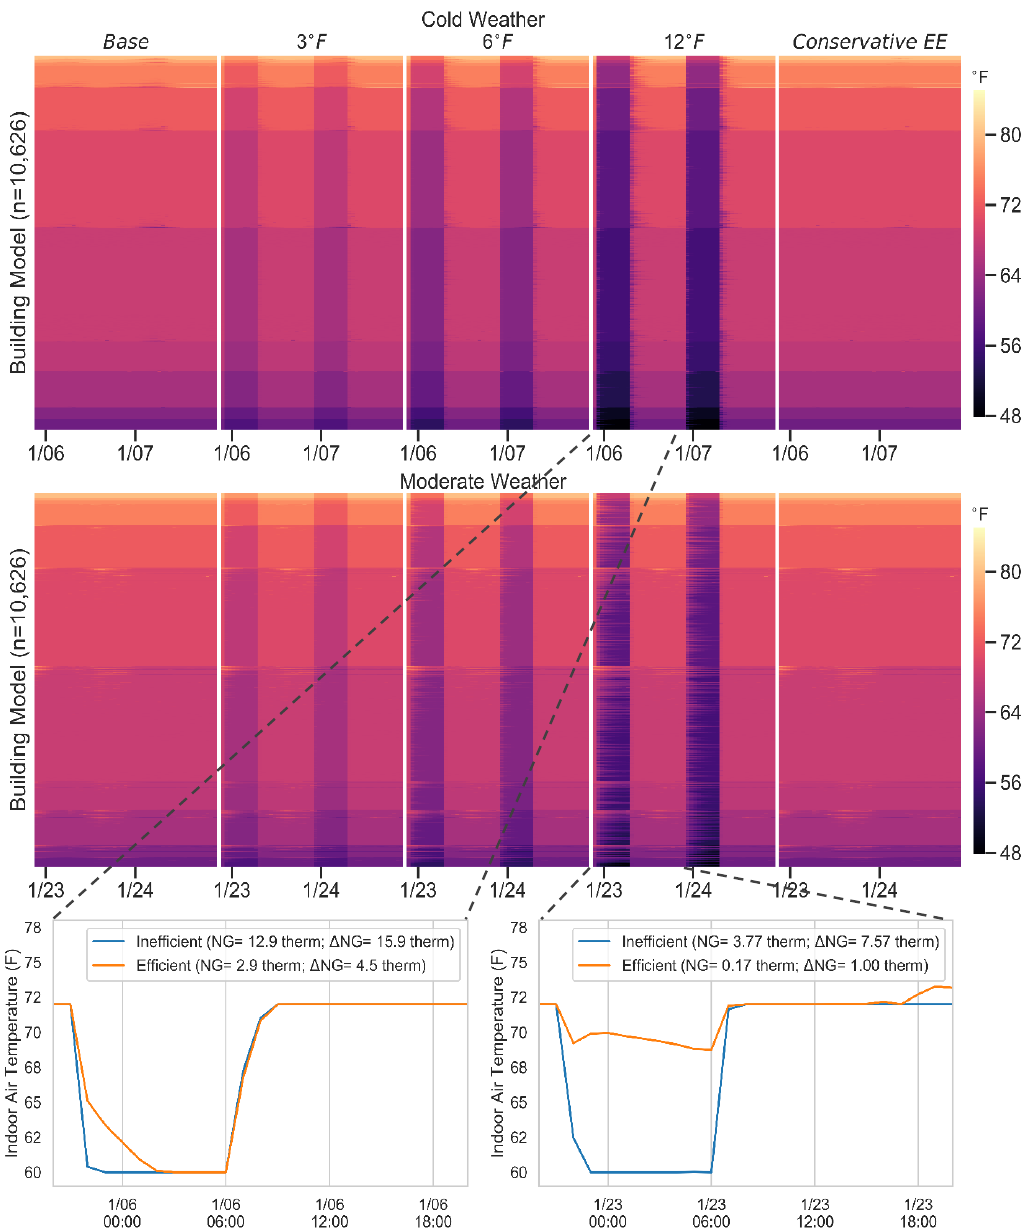
Figure 9. Heatmap of indoor air temperatures for the conservative approach during cold temperature ( top ) and moderate temperature ( bottom ) periods in 2018. The y -axis contains each building model for which the conservative setback was applied (46% of homes) and is sorted by average indoor air temperature. The lower two plots show expanded views of indoor air temperatures for two homes over 24 h during the cold period ( left ) and the mild period ( right ). One model is well insulated and tightly sealed (“Efficient”) and the other is poorly insulated and poorly sealed (“Inefficient”).